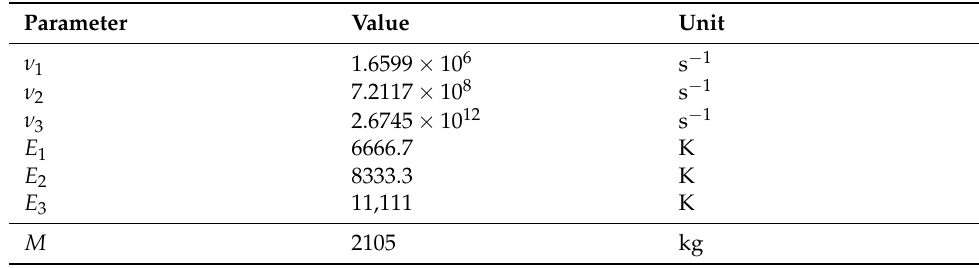
Table A1. Plant parameters and constants.